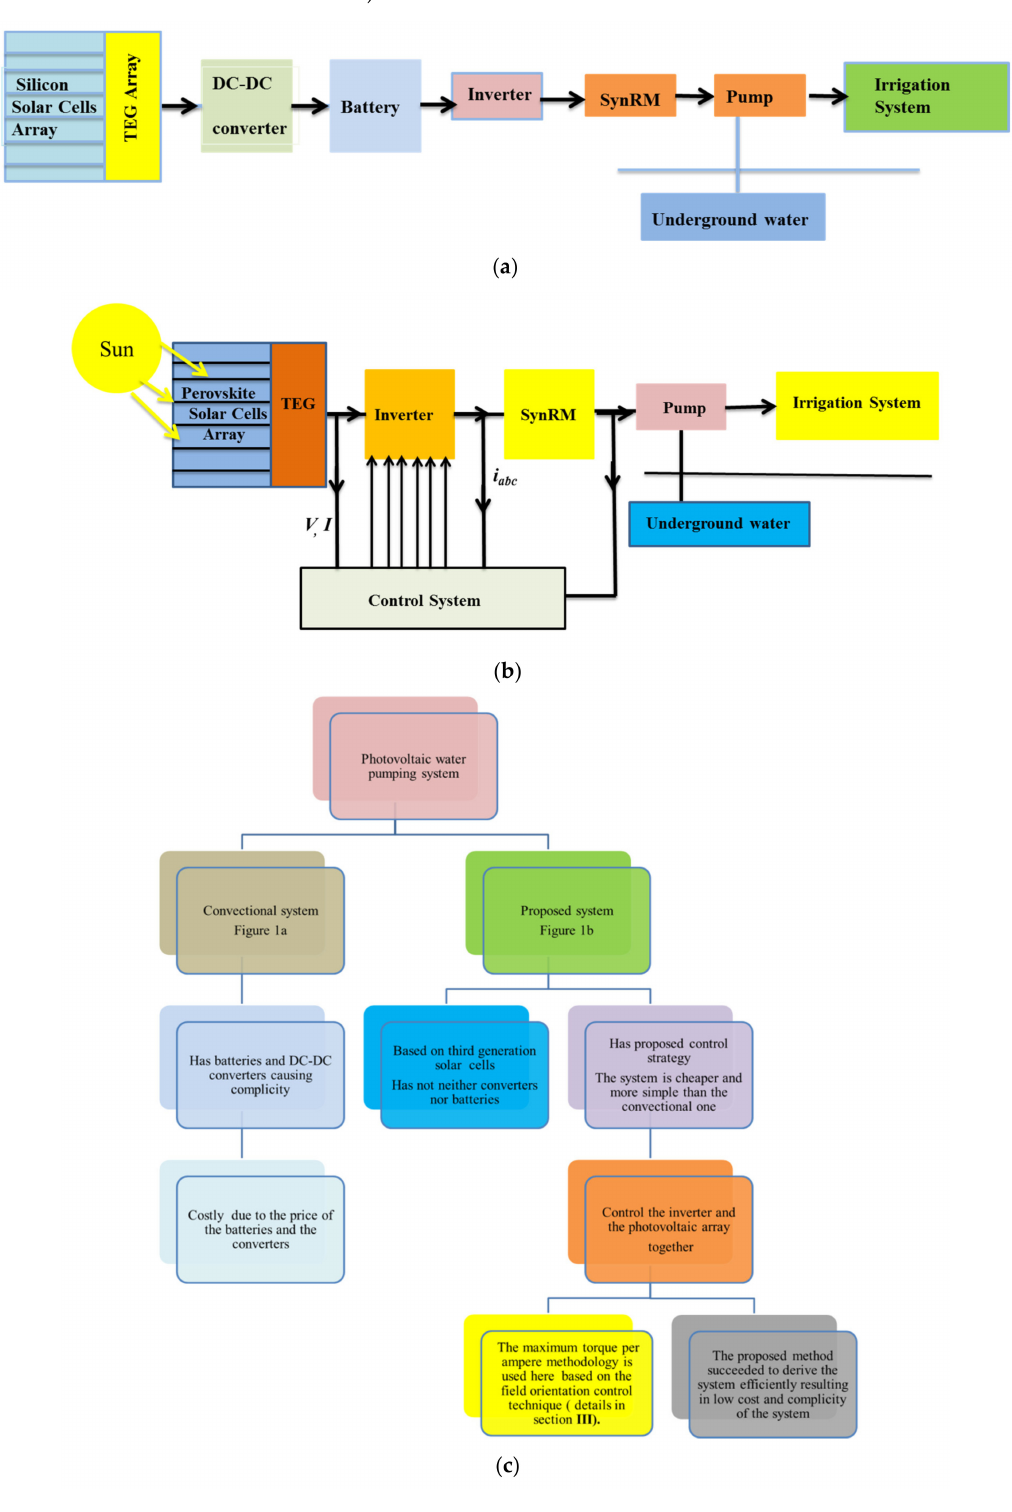
Figure 1. ( a ) The conventional photovoltaic water pumping system. ( b ) The proposed system schematic diagram. ( c ) The flow chart of the proposed